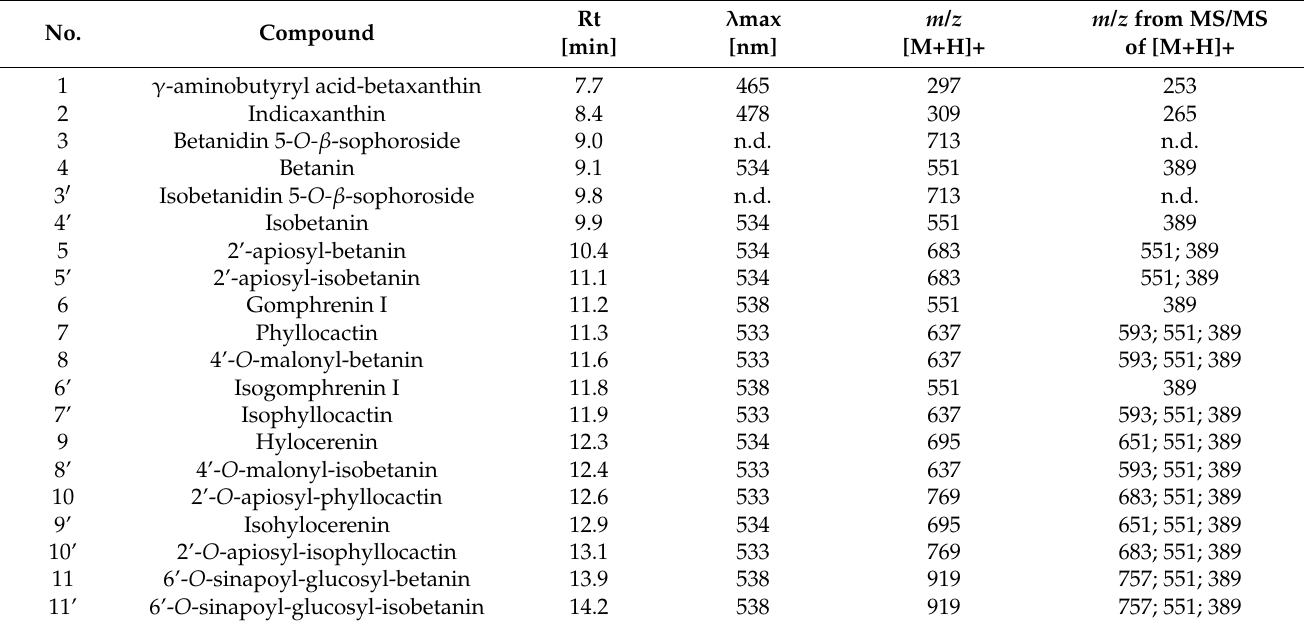
Table 1. Chromatographic, spectrophotometric, and mass spectrometric data of betalains identified in dry extracts of Epiphyllum , Hylocereus , and Opuntia